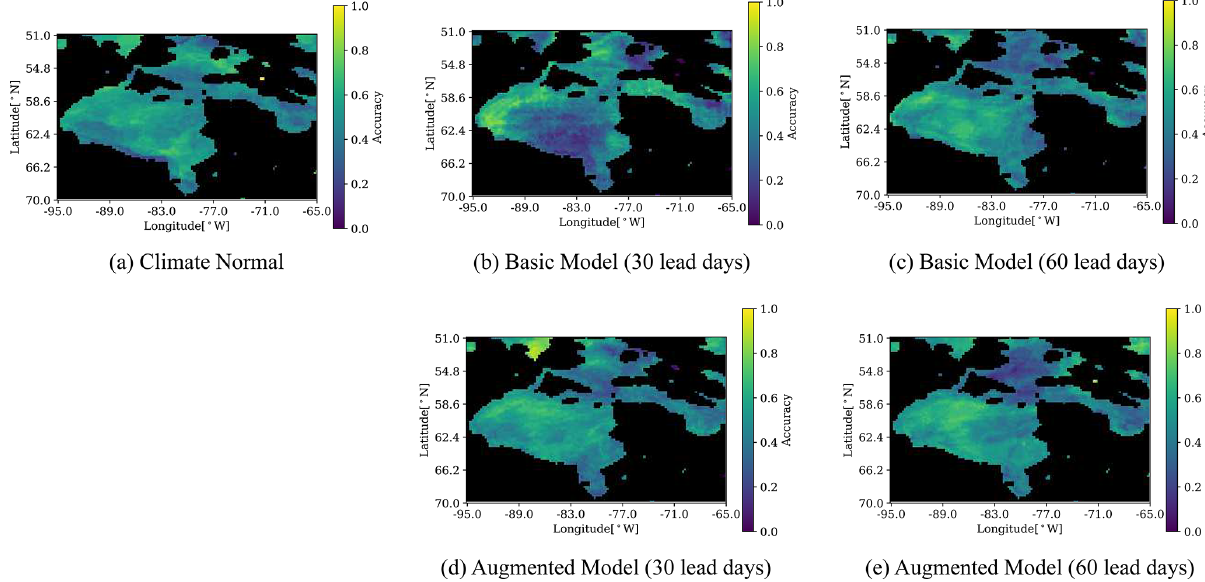
Figure 8. Accuracy of the predicted freeze-up date within 7d. Freeze-up dates are checked from 1 October to 31 January. The 7d window is chosen to match to the definition used by the Canadian Ice Service.